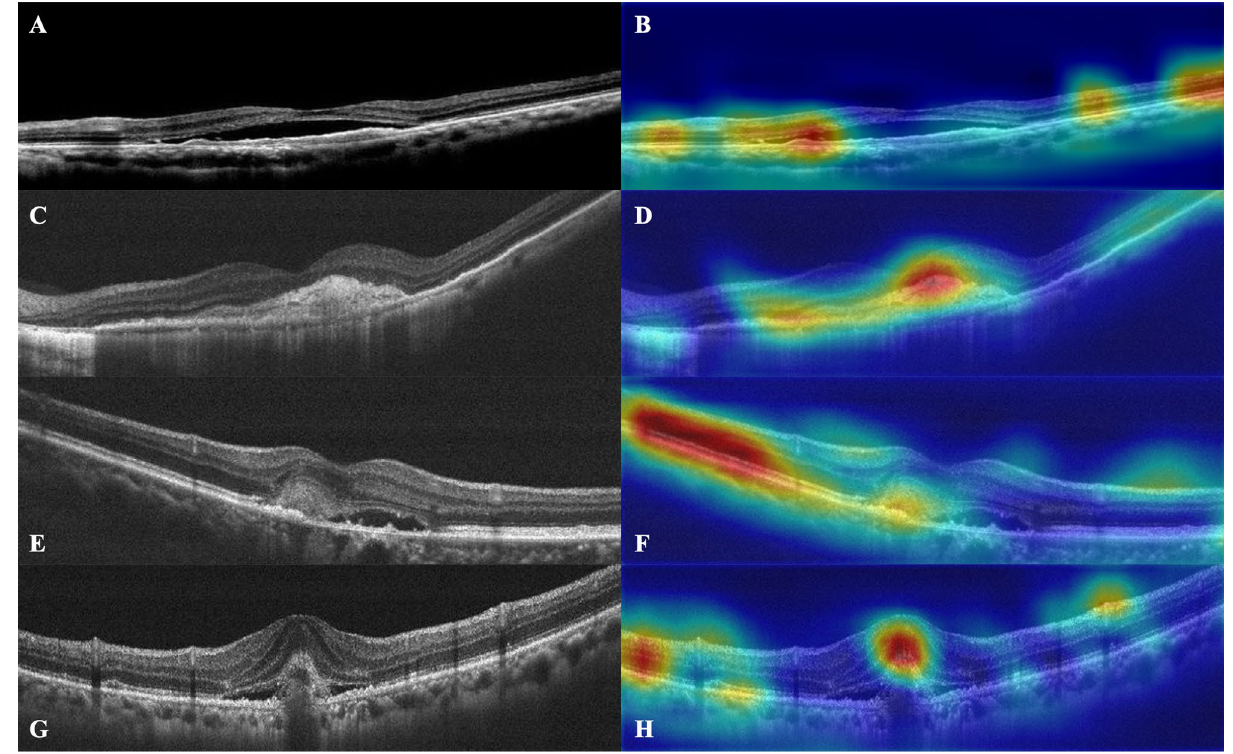
Figure 4. Representative horizontal scans of SD-OCT and corresponding superimposed heatmaps. Presented are ( A ) an example of an OCT image with the HDF-Net correctly predicted as an improved case (85 M; baseline VA:0.2; 12th month VA: 0.5); ( B ) The network located attention on the margin of SRF, and on retinal pigment epithelial mottling. Also, some attention corresponded to islands of preserved ellipsoid zone (EZ) reflecting preserved visual potential. ( C ) An example of an OCT image with the HDF-Net correctly predicted as an unimproved case (94 M; baseline VA:0.05; 12th month VA: 0.1); ( D ) The attention is located at the subfoveal disciform scar and disruption of the EZ. There is also some attention on the chorioretinal atrophy with adjacent loss of outer retinal layers. ( E ) An example of an OCT image with the HDF-Net predicted to improve but the patient failed to achieve VA improvement > = 2 lines (96 M; baseline VA:0.4; 12th month VA: 0.4); ( F ) The attention is located primarily on the preserved EZ and the subretinal hyperreflective material (SHRM) with fibrovascular components. A relatively normal fovea contour was also identified. ( G ) An example of an OCT image with the HDF-Net predicted not to improve but the patient demonstrated VA improvement > = 2 lines (82 M; baseline VA:0.4; 12th month VA: 0.6); ( H ) The attention is located on the SHRM with fibrovascular/ hemorrhagic components. Also some attention on the disruption of the EZ and the hyperreflective zone of the inner